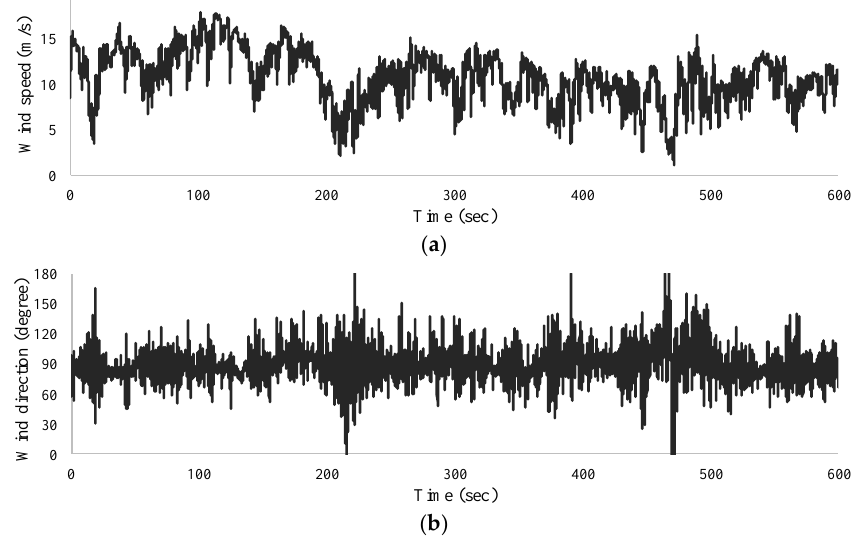
Figure 11. Time history of wind data: ( a ) wind speed and ( b ) wind direction.